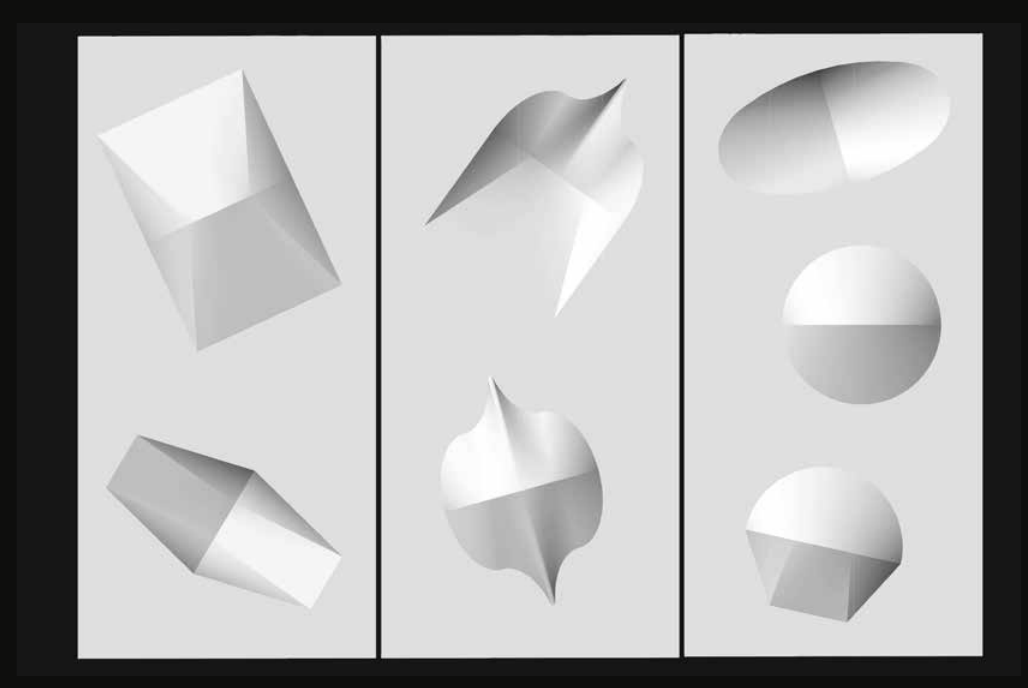
Figure 9: If either an electromagnet or weight bag fixity method can be made workable, complex and site-designated deformation of larger panels would be possible, putting both placement and deformation depth at the discretion of the tool user. Source: